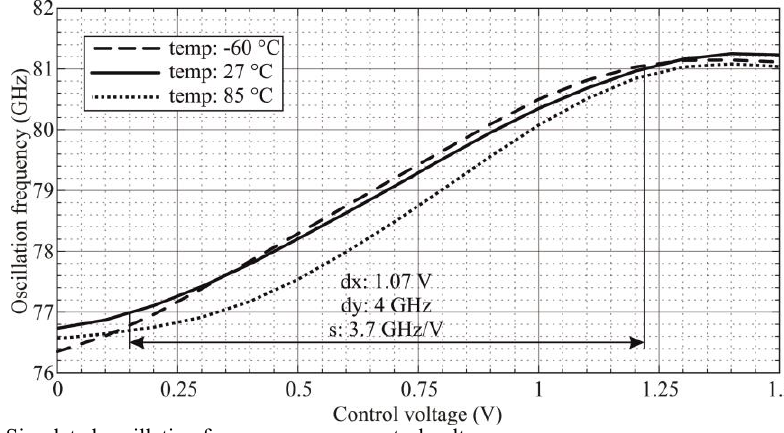
Fig. 3. Simulated oscillation frequency versus control